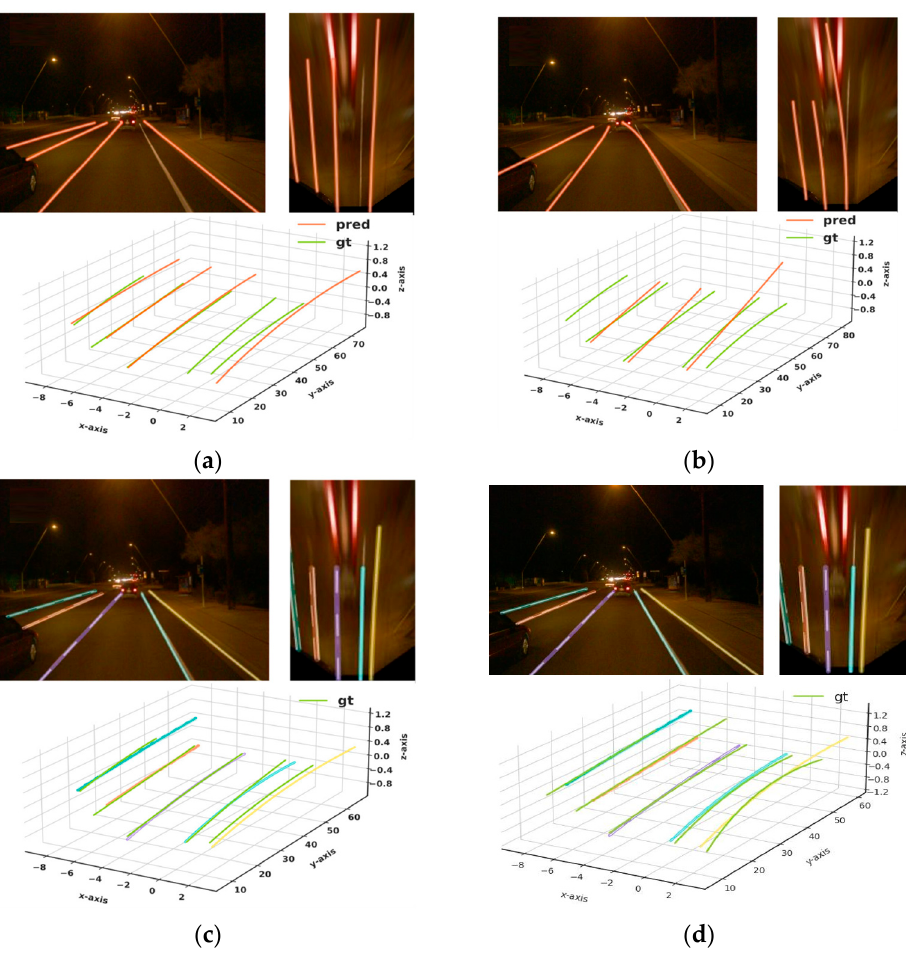
Figure 6. Qualitative comparison between: ( a ) 3D-LaneNet [34], ( b ) Gen-LaneNet [35], ( c ) PersFormer [13], and ( d ) proposed method on night case.